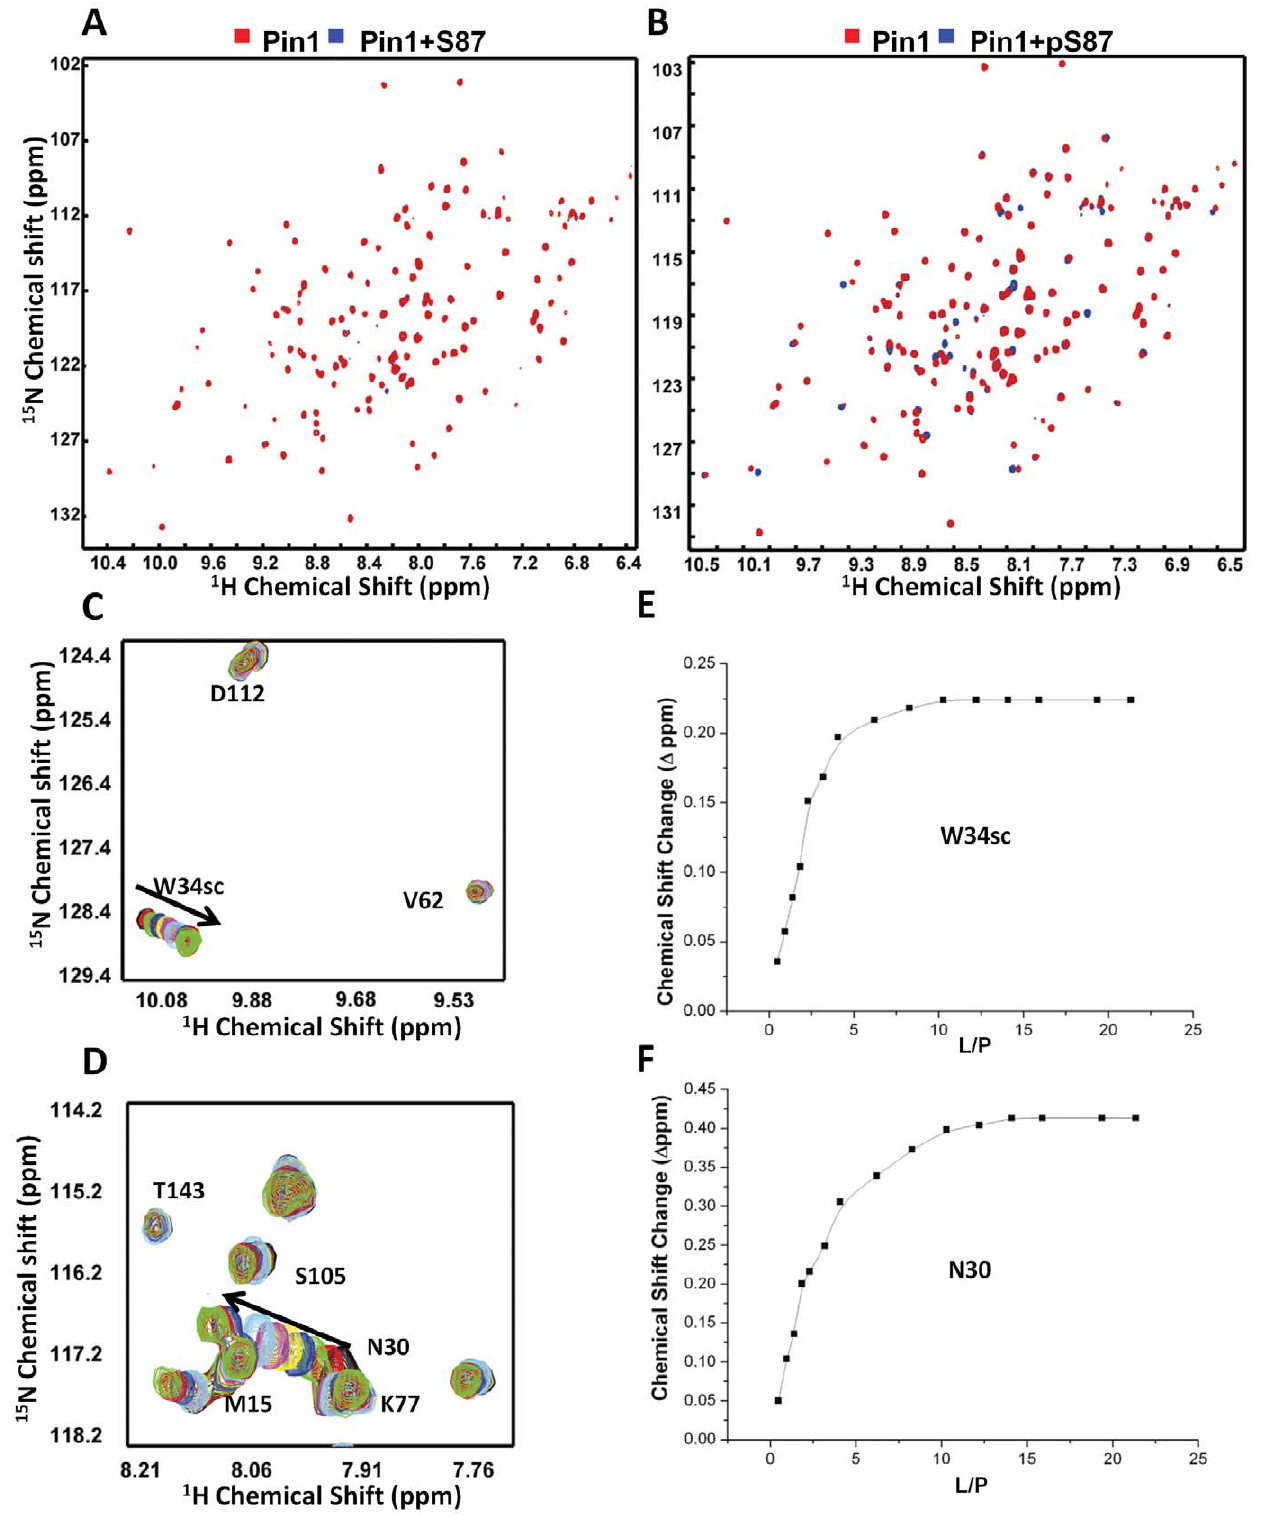
Figure 3. Pin 1 binds to the phosphopeptide derived from the flexible loop of Bcl-2. The 15 N-labeled Pin1 (0.1 mM) was recorded with (A) 0.8 mM S87 and (B) phosphorylated S87 (pS87). The 1 H- 15 N-HSQC spectra with or without peptide are show in blue and red, respectively. (C, D) Some of the amino acid chemical shifts change with the increasing peptide concentration. The arrows show the direction of chemical shift perturbations with an increasing concentration of ligand. (E, F) The relationship between chemical shift change and the ratio between ligand and protein was drawn. Values of K D were calculated from the graphs using the equation described in ‘‘Materials and methods’’.